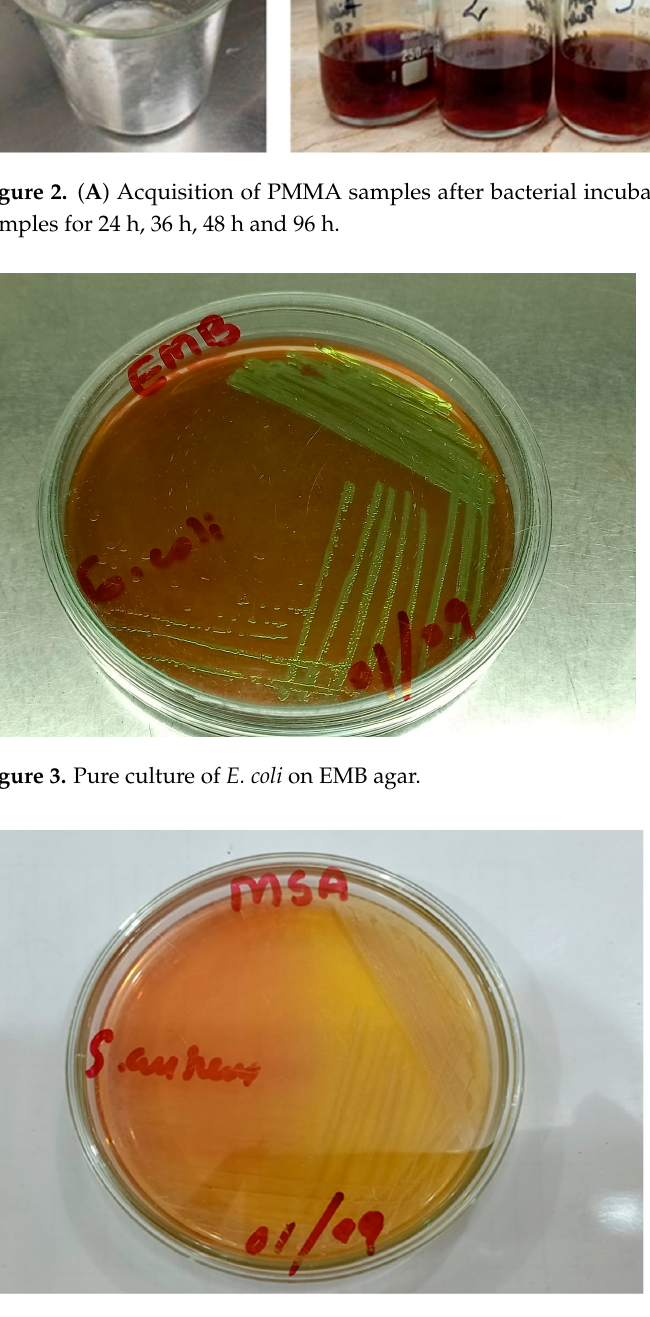
Figure 4. Pure culture of S. aureus on Mannitol Salt agar.